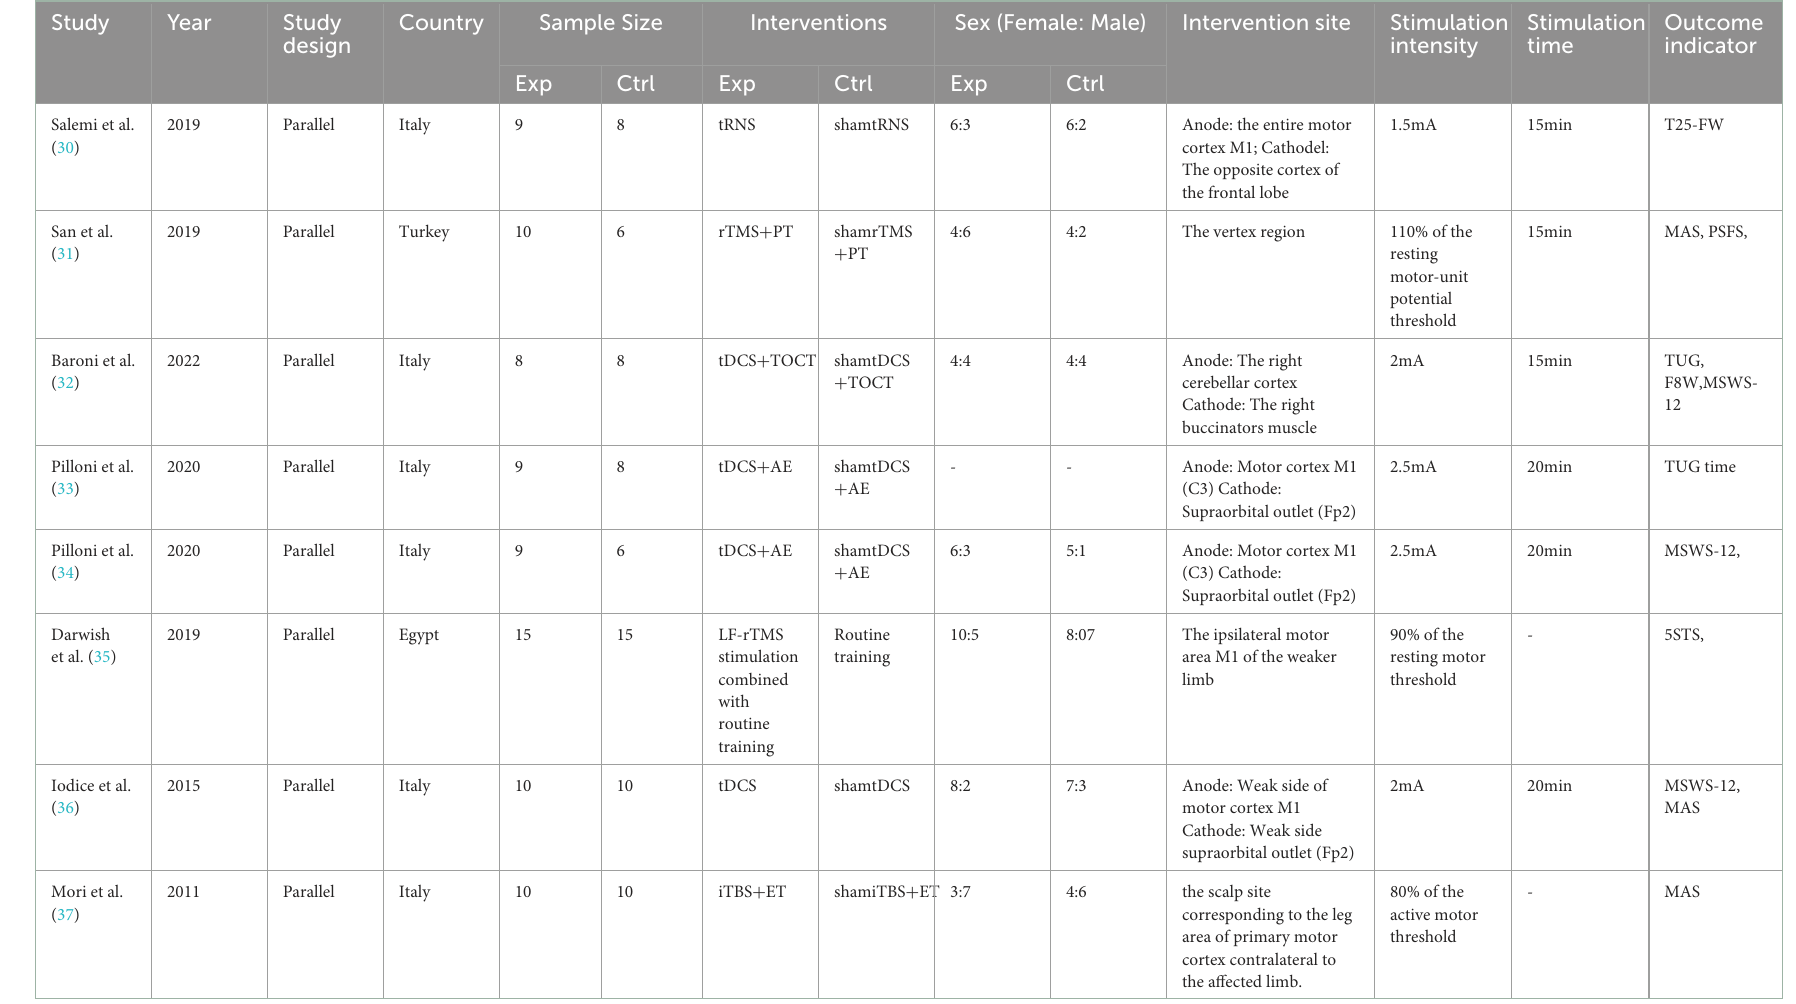
TABLE 2 Included motor-related studies characteristics.